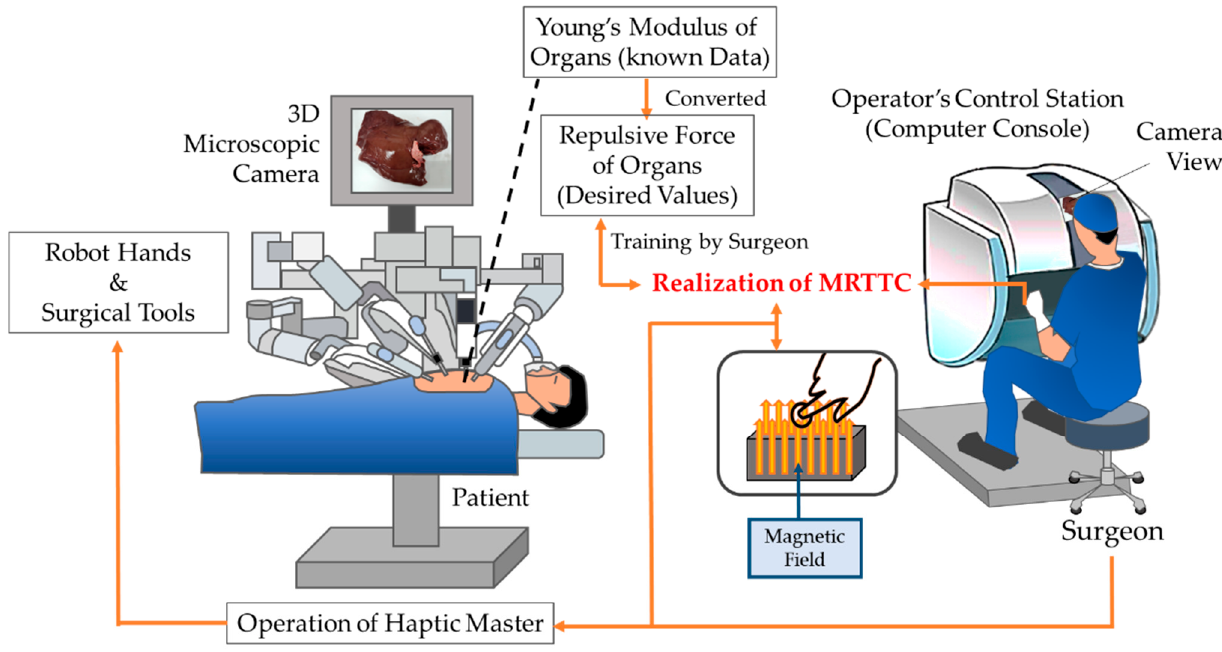
Figure 1. Conceptual diagram of the proposed MRTTC: how to transfer tactile information during robot-assisted minimally invasive surgery.